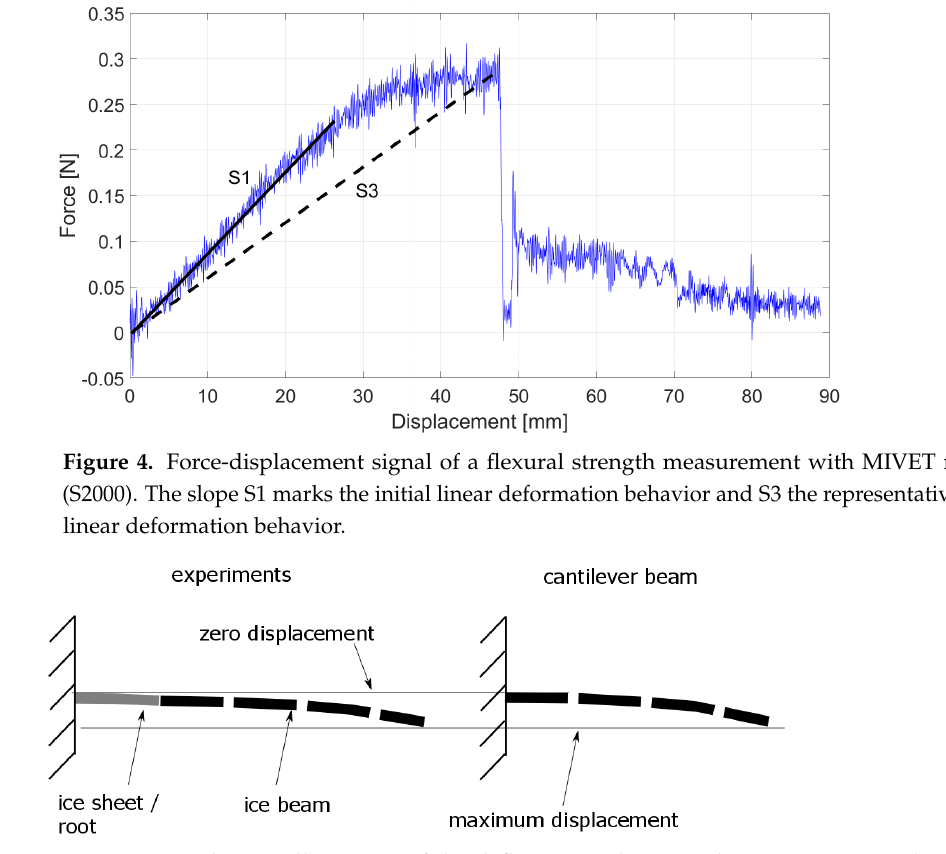
Figure 5. Qualitative illustration of the deflecting ice beam in the experiments and its accurate representation in the finite element model ( left ) versus an analytical cantilever beam model ( right